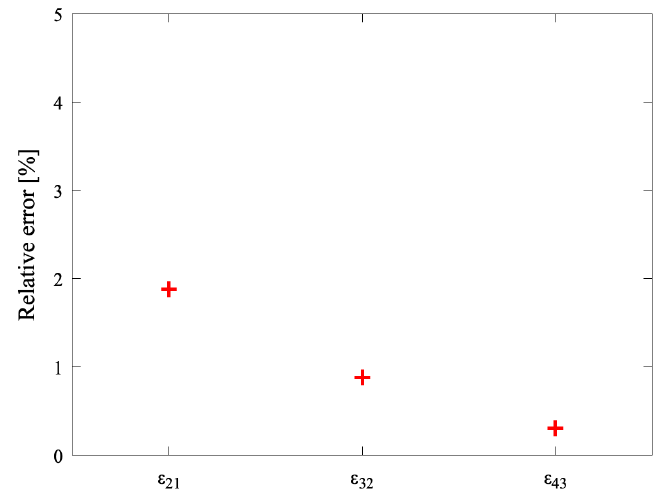
Figure 7. Relative errors between the four grids.